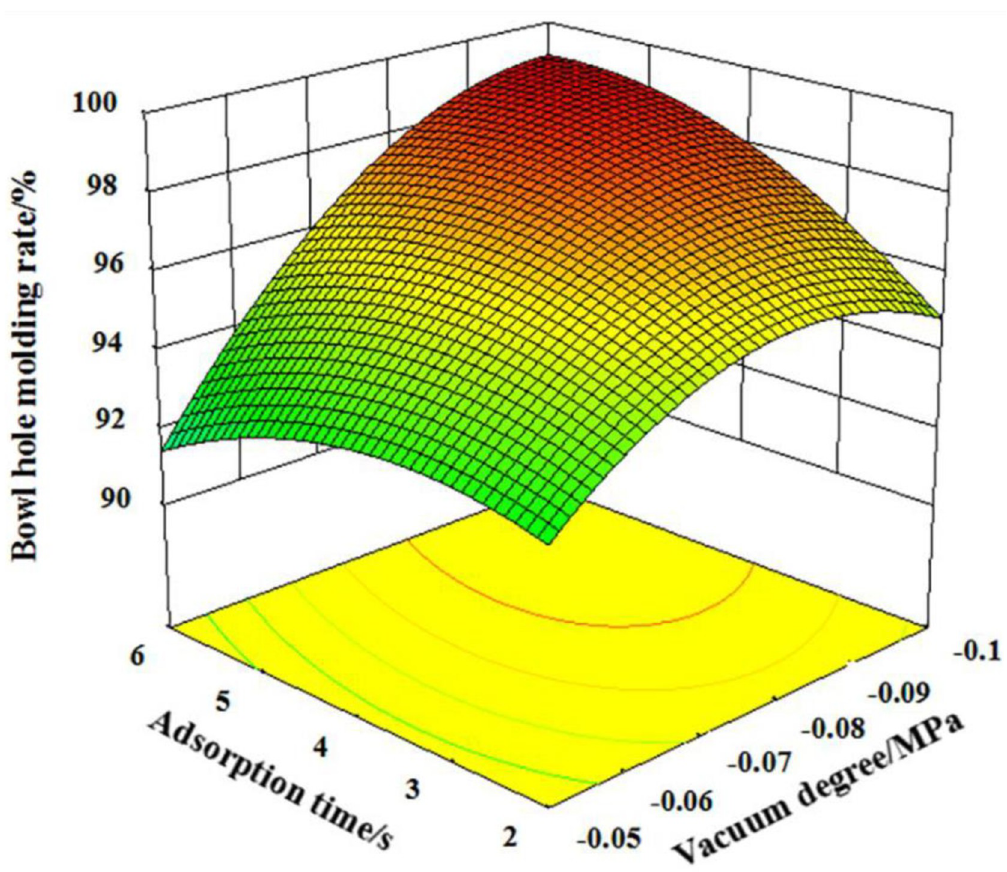
Fig 7. The interaction of vacuum degree and adsorption time on the bowl hole molding